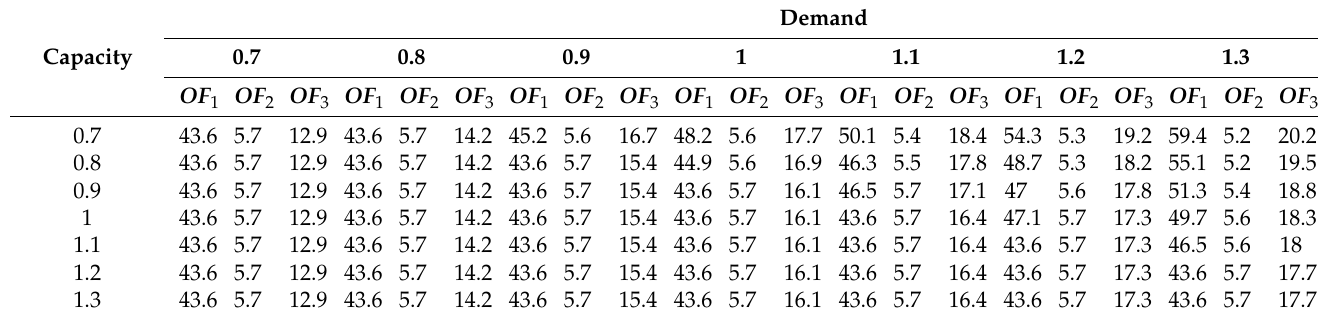
Table 8. Sensitivity analysis of the changes in vehicle capacity and demand functions simultaneously.